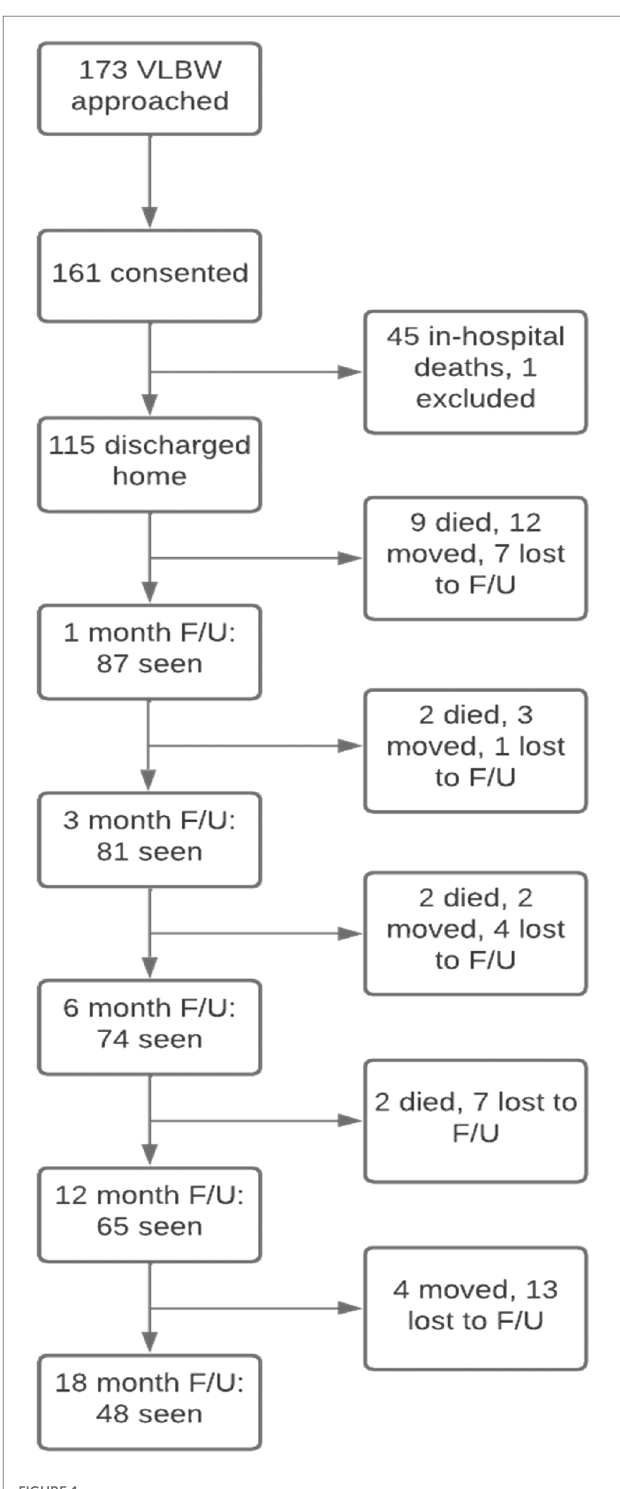
FIGURE 1 Flowchart of numbers of participants at each point of follow-up. One infant missed 1 and 3-months ’ , but attended 6 – 18 months ’